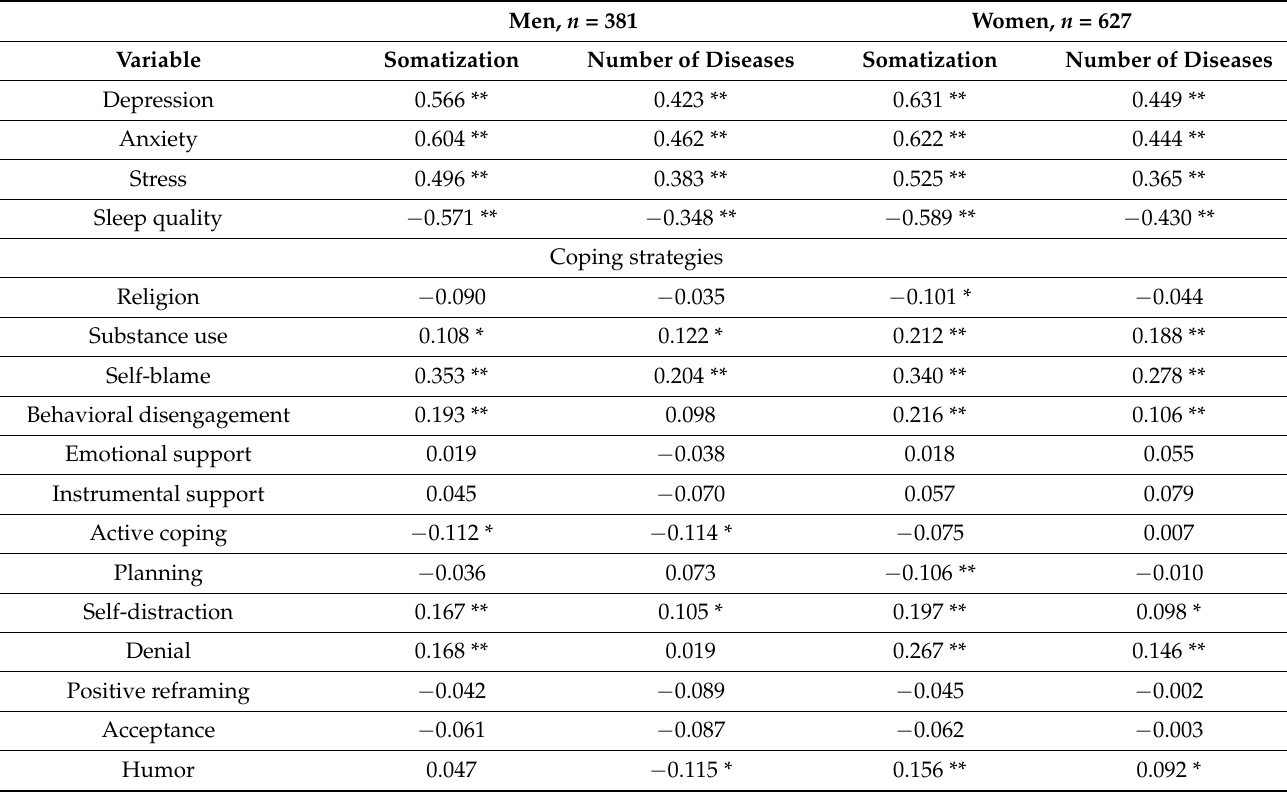
Table 4. Bivariate correlations between psychological variables and coping strategies and somatiza- tion and number of diseases in each